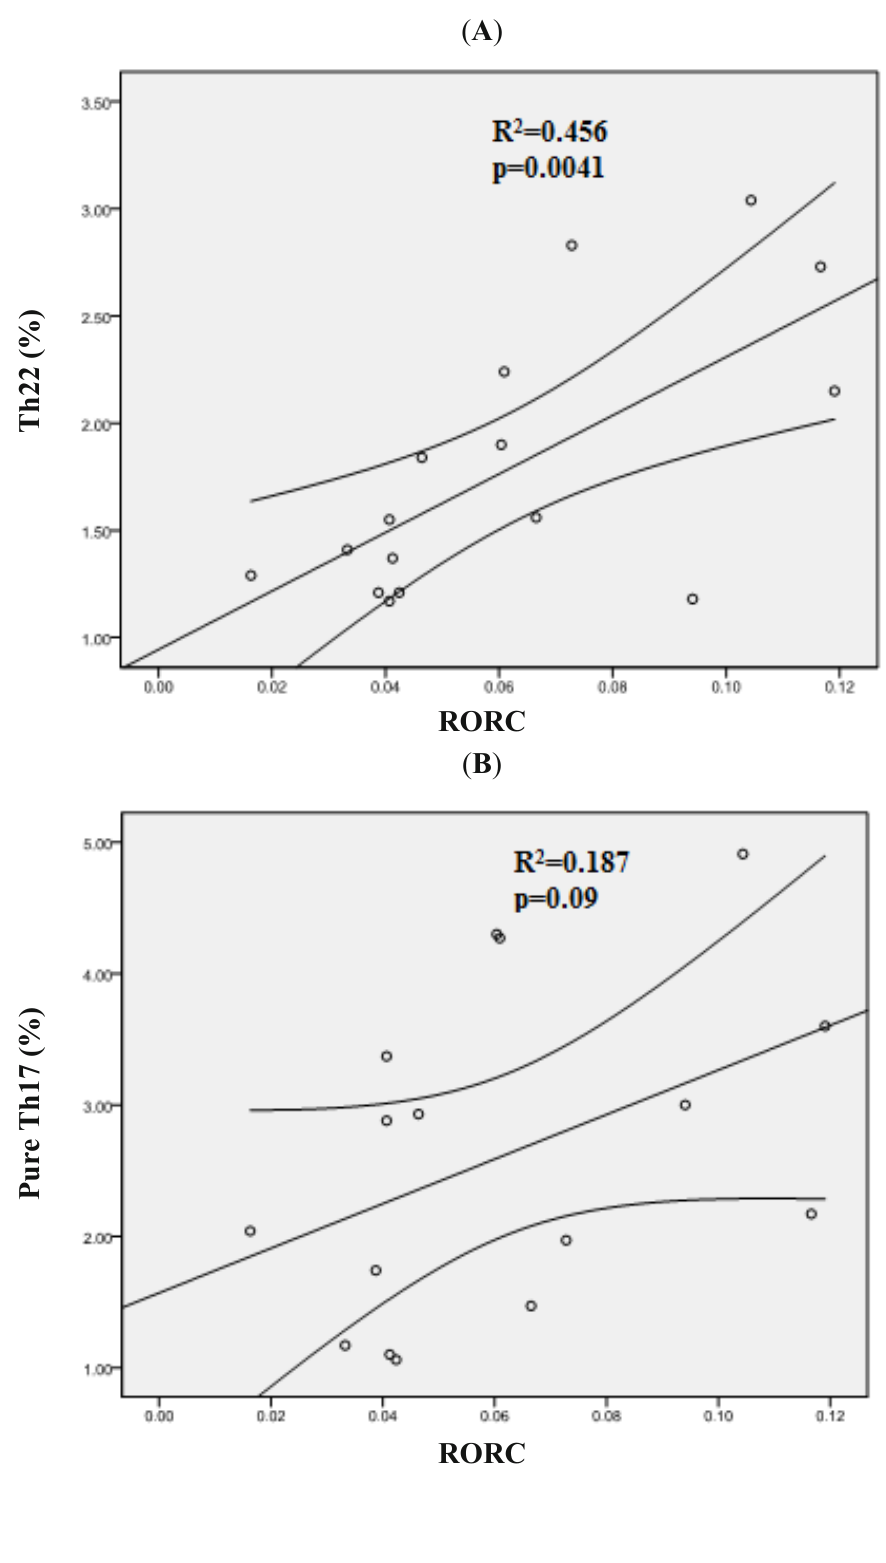
Figure 6. Correlations between RORC and Th subsets in AML patients. ( A ) RORC showed the positive correlation with Th22 cells in Non-CR AML patients; ( B ) RORC showed the negative correlation with Th1 cells in Non-CR AML